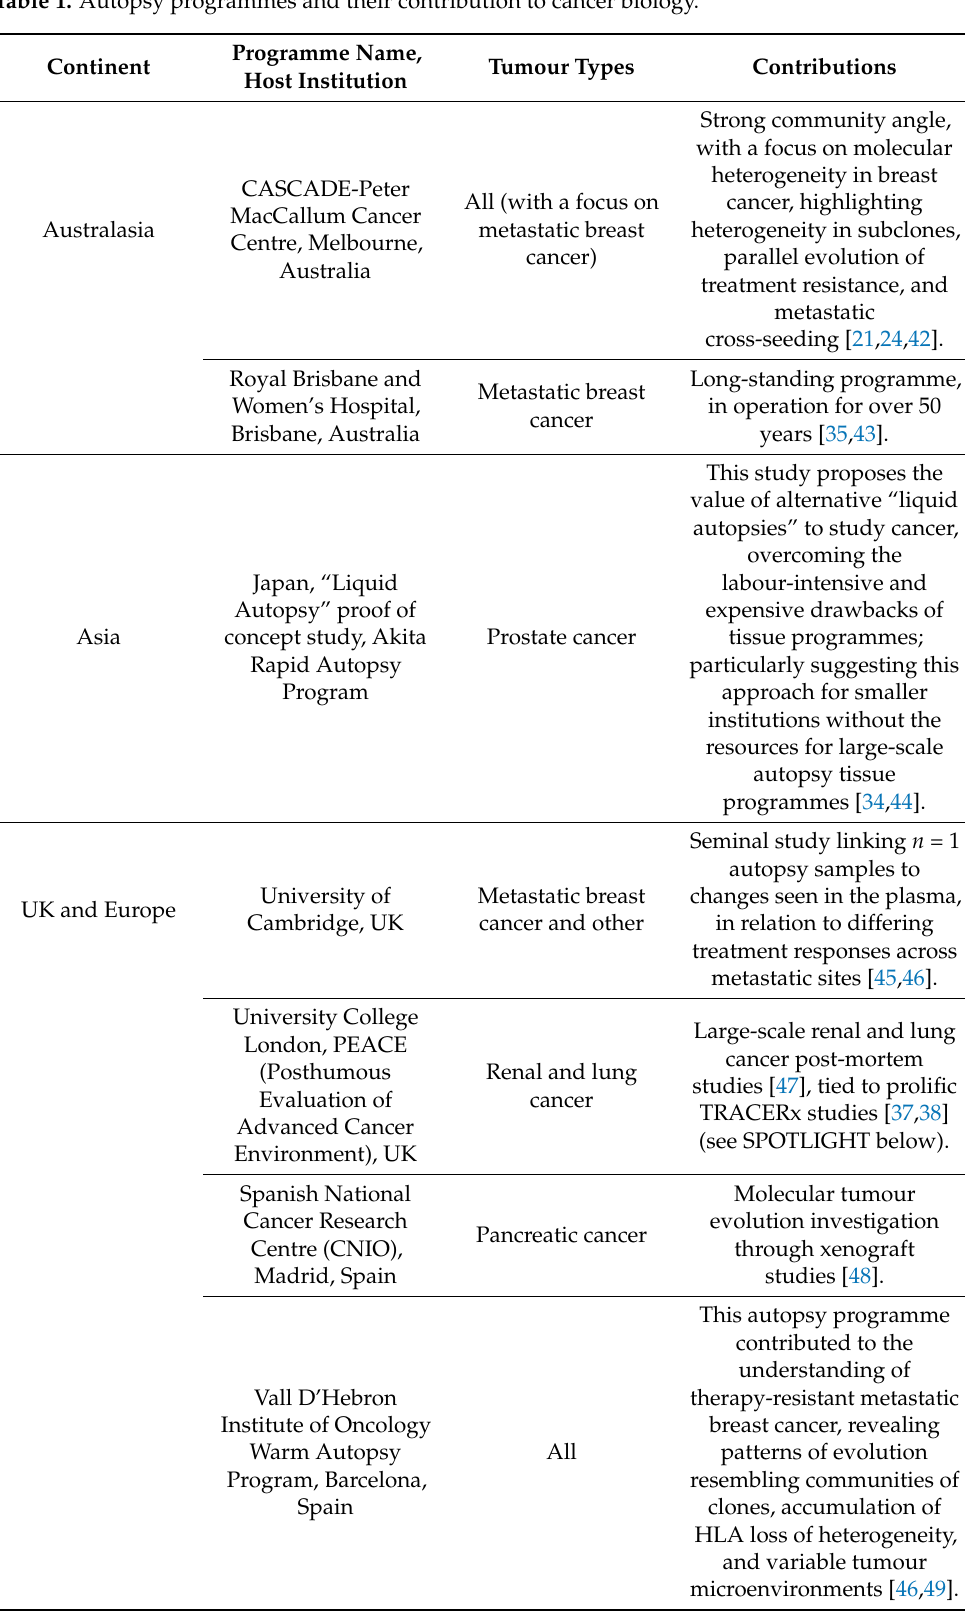
Table 1. Autopsy programmes and their contribution to cancer